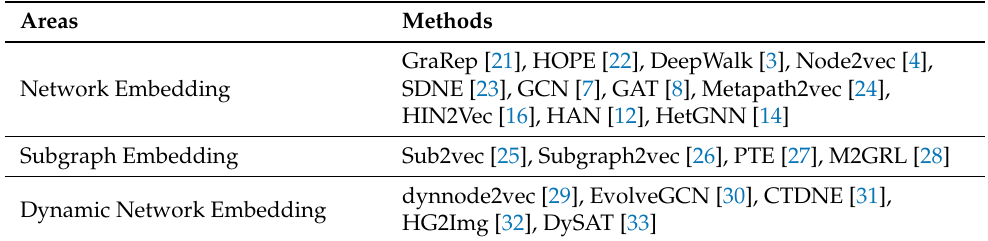
Table 1. Typical methods in three